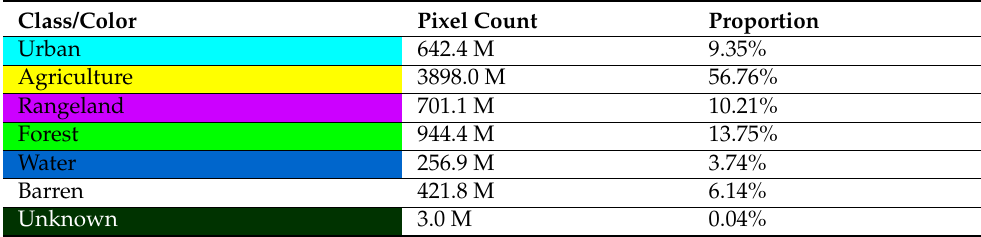
Figure 1. The land cover original image (left) and class label (right) pairs. Table 1. Classes in the label data of the DeepGlobe dataset.